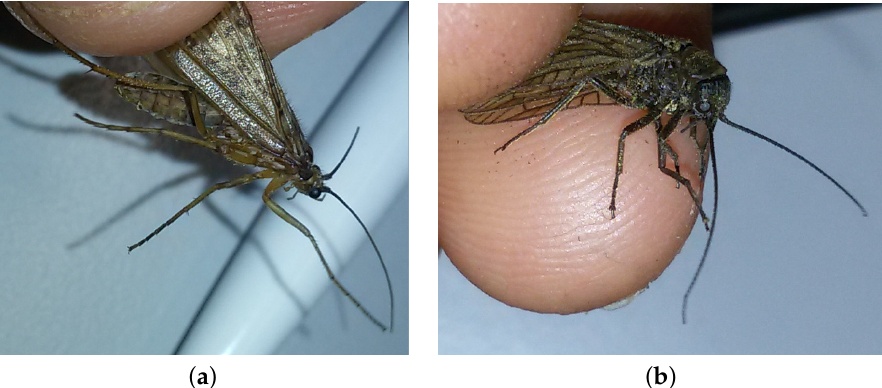
Figure A2. Caught flying insects: ( a ) Phryganea grandis for Experiment I, ( b ) Sialis lutaria for Experi- ment II.